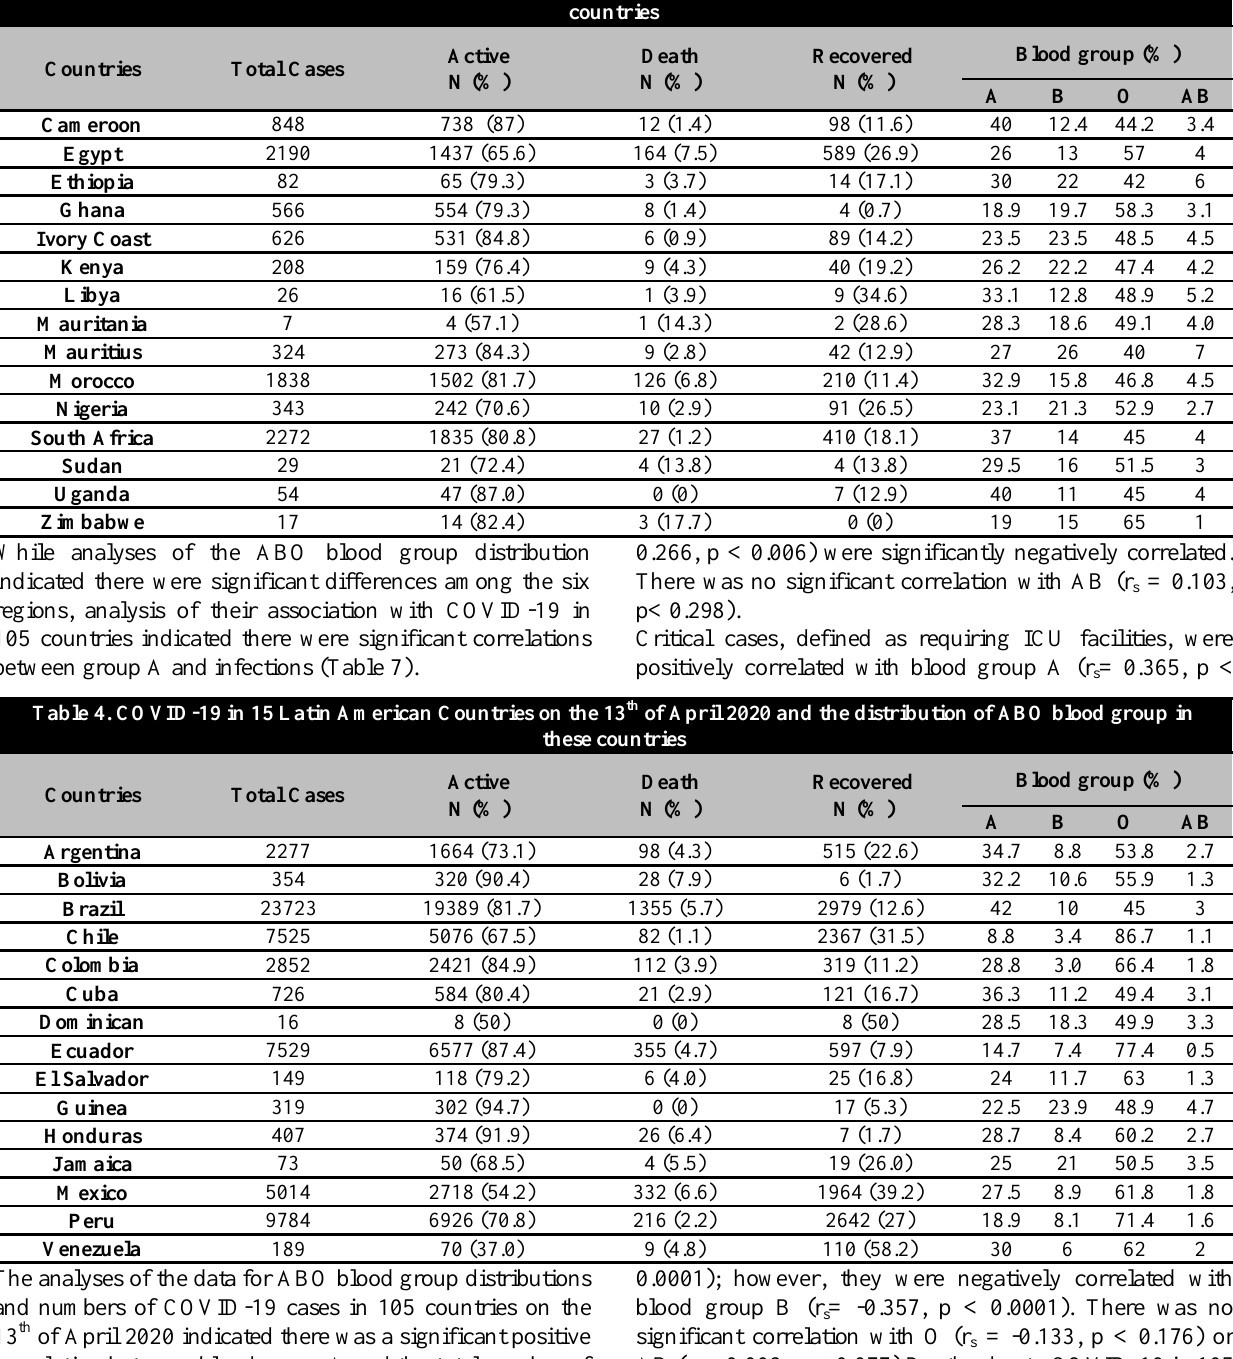
Table 3. COVID-19 in 15 African Countries on the 13 th of April 2020 and the distribution of ABO blood group in these